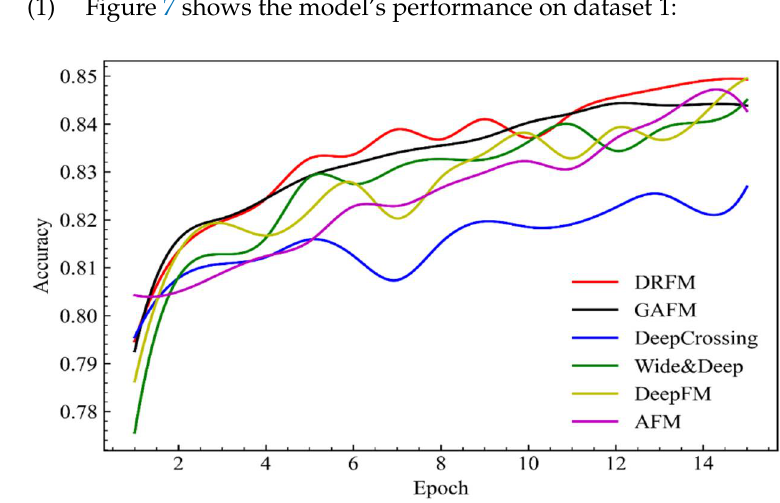
Figure 7. Accuracy of each model in dataset 1. (2) Figure 8 shows how the model behaves in dataset 2: